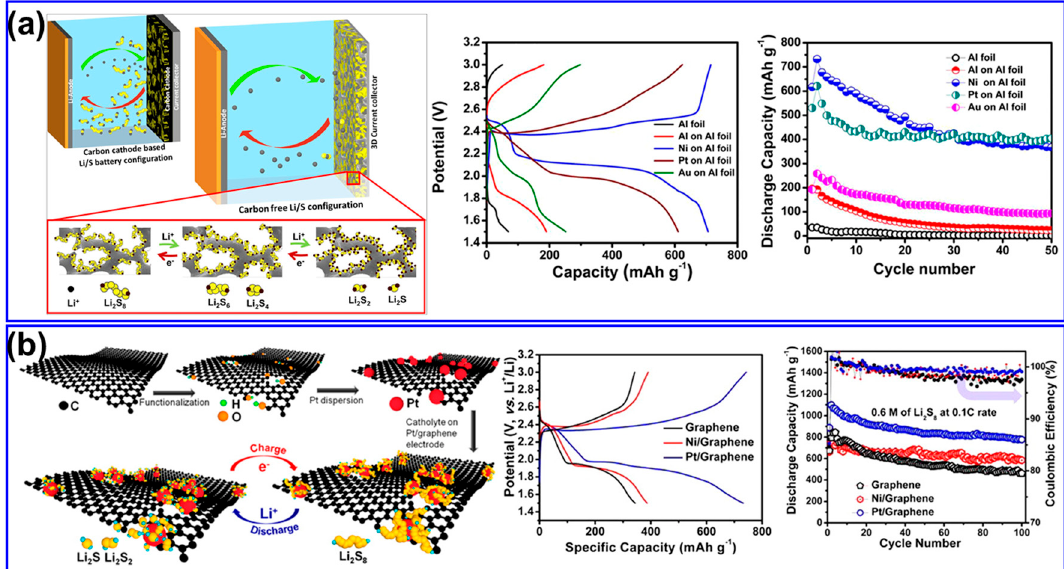
Figure 2. ( a ) Left: Schematic representation of Li-S battery configuration based on conventional carbonaceous cathode versus novel metal-based current collector (inset representing the anchoring of LiPS on the surface of 3D current collector). Middle: Comparison of charge–discharge plateaus. Right: Cycling behavior of different electrocatalysts on Al substrate. Reproduced with permission, Copyright, 2015, Springer Nature [60]. ( b ) Left: Illustration of Pt anchored on graphene nanocomposite preparation and its interaction with LiPS during charge/discharge process. Middle and Right: Charge/discharge plateaus and cycling behavior along with coulombic efficiency of pristine and electrocatalyst anchored graphene electrodes at 0.1 C rate. Reproduced with permission, Copyright, 2015, American Chemical Society [61].